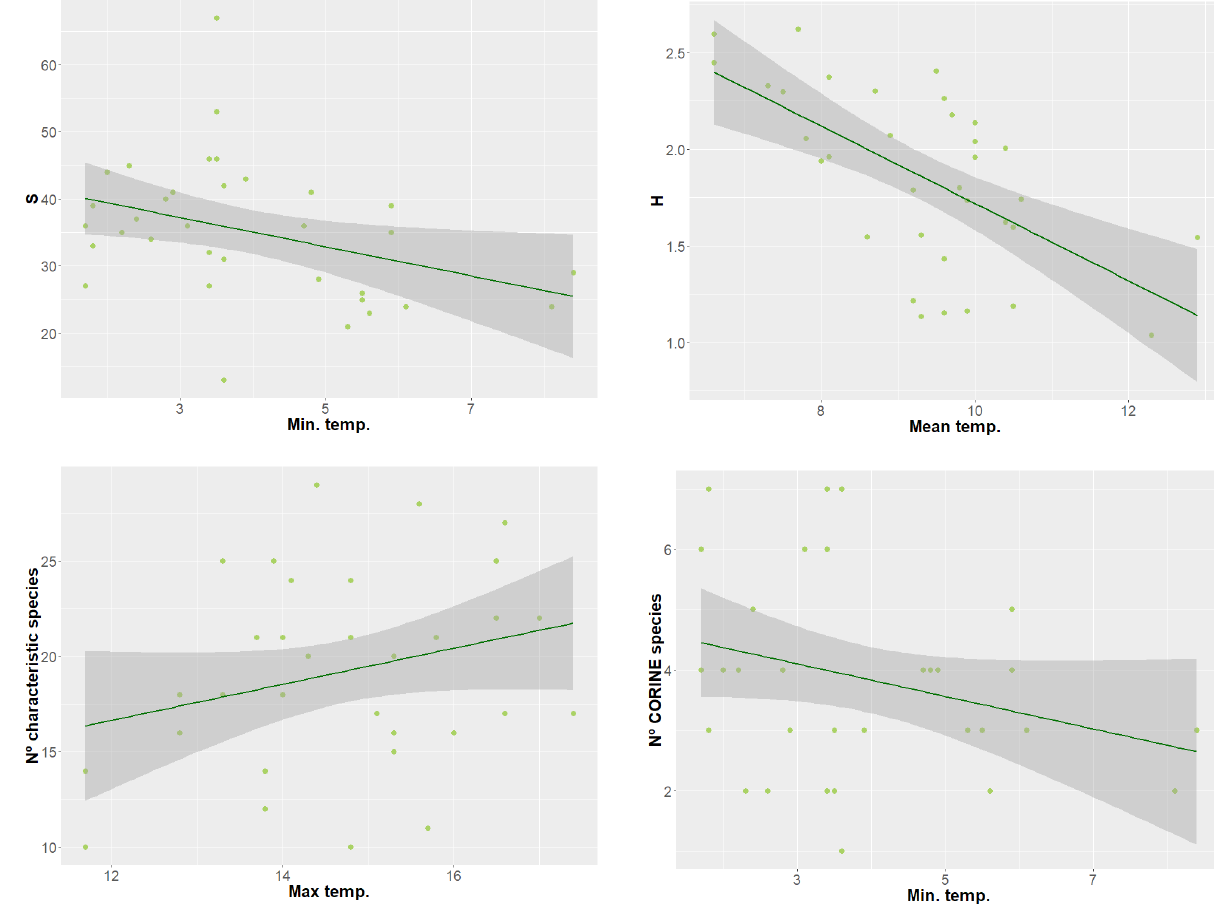
Figure 2. Conservation indicator variations for the sessile oak forests along climatic variables according to GLM fits. Is the protection of this habitat